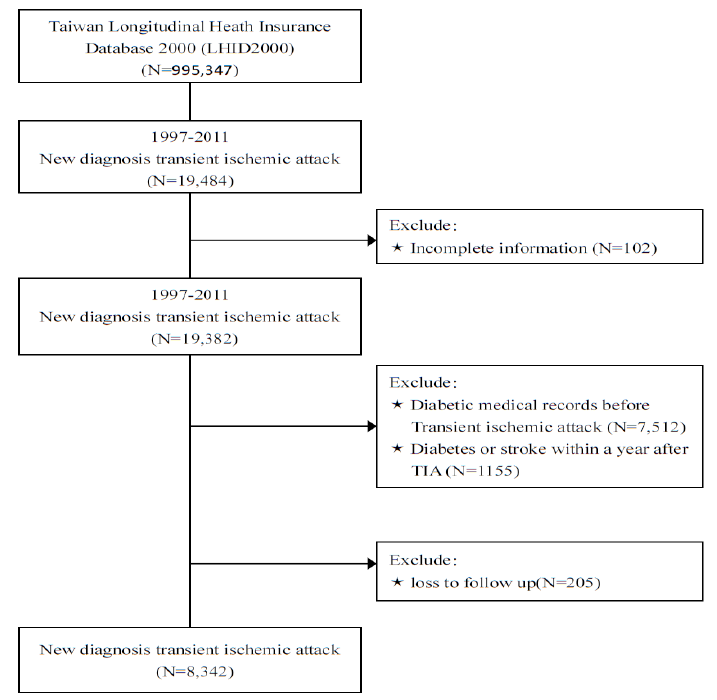
Figure 1. Flow chart for the enrollment of participants in the study.